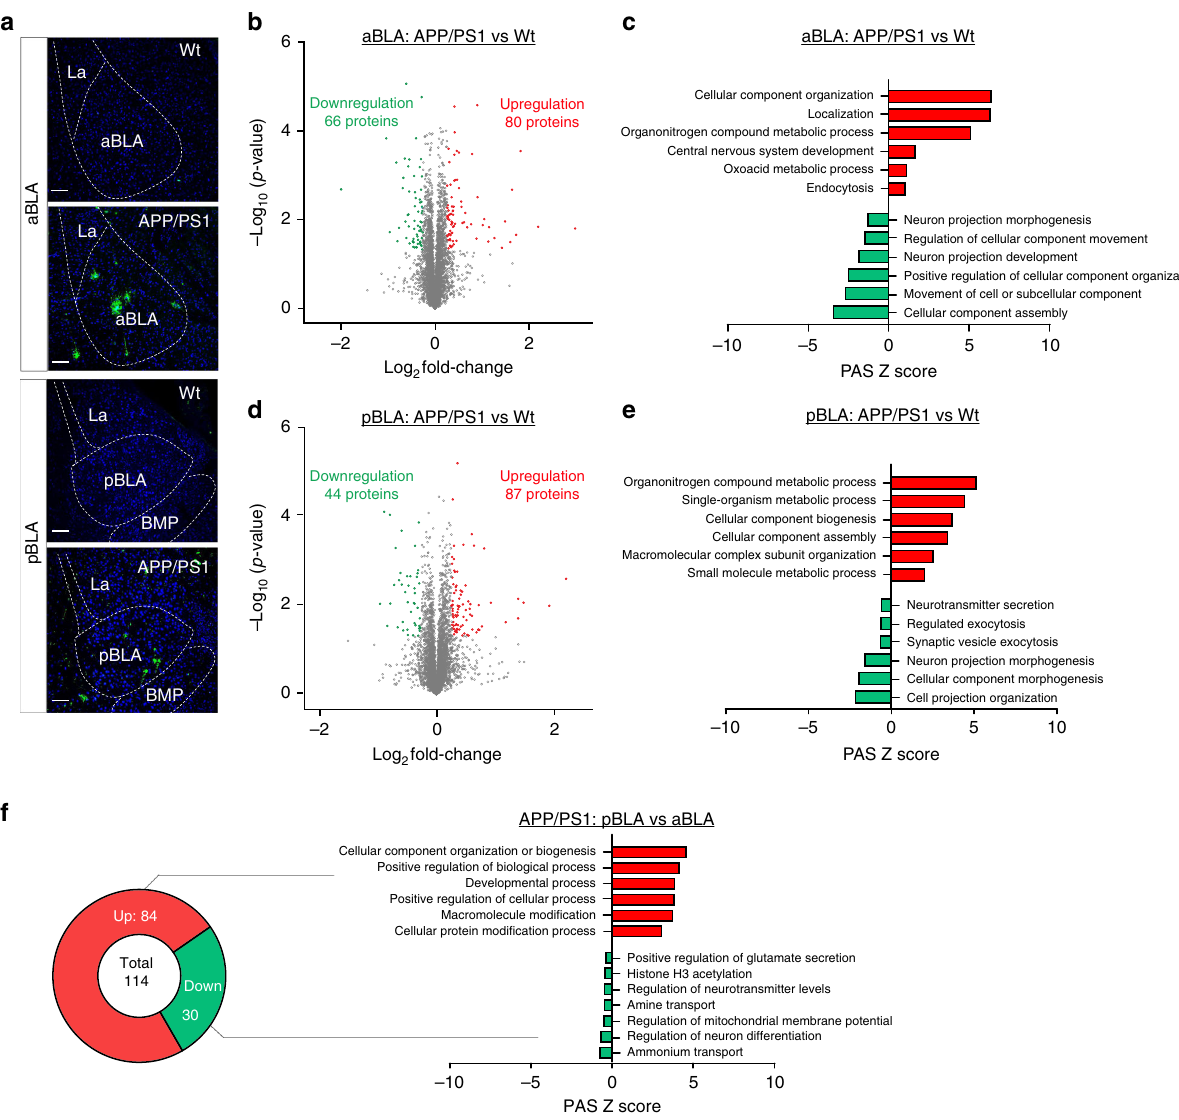
Fig. 5 Proteomics reveals distinct molecular changes in the aBLA versus pBLA of APP/PS1 mice. a Representative images of A β pathology in the aBLA and pBLA by 6E10 staining. Scale bar, 100 μ m. Volcano plot showing protein changes in the aBLA ( b ) and pBLA ( d ) in 6 - month - old APP/PS1 versus wild- type (Wt) mice. Red and green dots represent proteins whose abundance is signi fi cantly increased or decreased. GO enrichment analysis of up- and downregulated GO categories in the aBLA ( c ) and pBLA ( e ) of APP/PS1 mice versus Wt mice, or GO categories differentially regulated in pBLA versus aBLA of APP/PS1 mice ( f ). n = 3 mice per group.